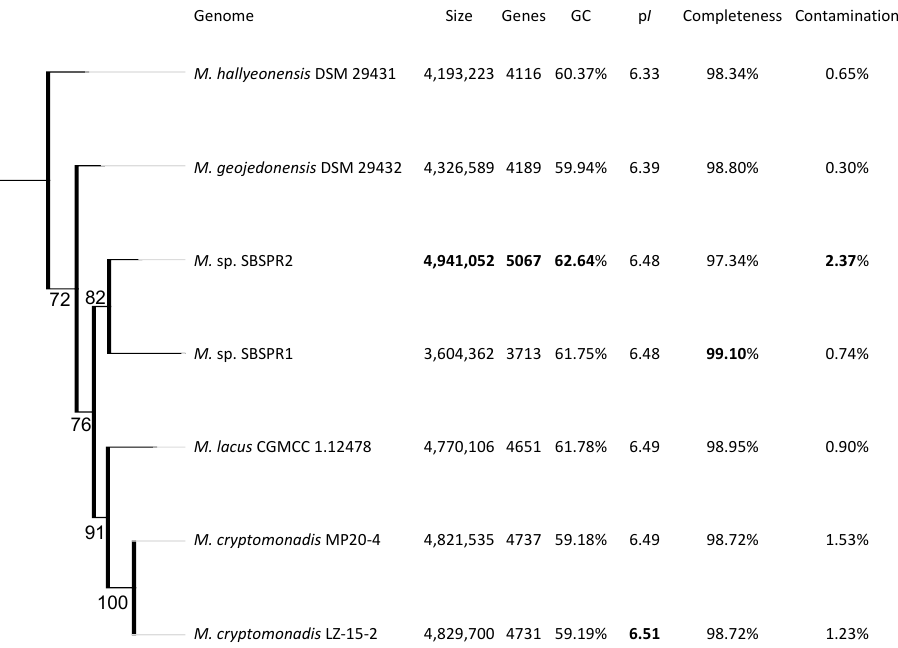
Figure 1. RAxML phylogenetic tree of the genus Marivita . The tree was built with a concatenated alignment of 120 single-copy bacterial genes and the PROTGAMMALG model of amino acid substitution. Branch labels show the bootstrap support, calculated with 1000 bootstraps. The genome size, number of protein coding genes, percentage G + C content, percentage completeness and contamination estimates from CheckM, and RefSeq ID are also shown. Bolded values highlight the greatest values in each column. The tree is rooted with Bacillus subtilis strain 168 as an outgroup (not shown).